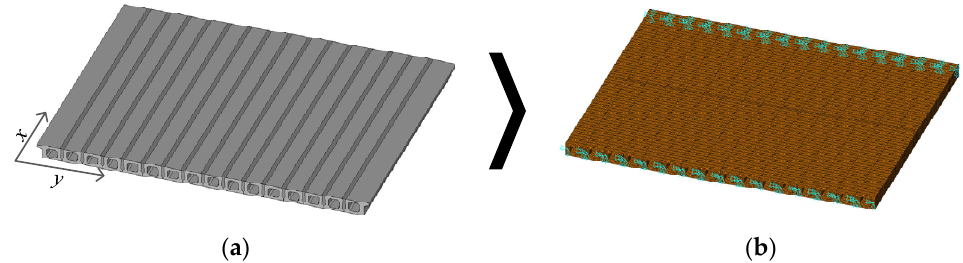
Figure 2. The model of a hollow sab bridge: ( a ) geometric model; ( b ) finite element model.